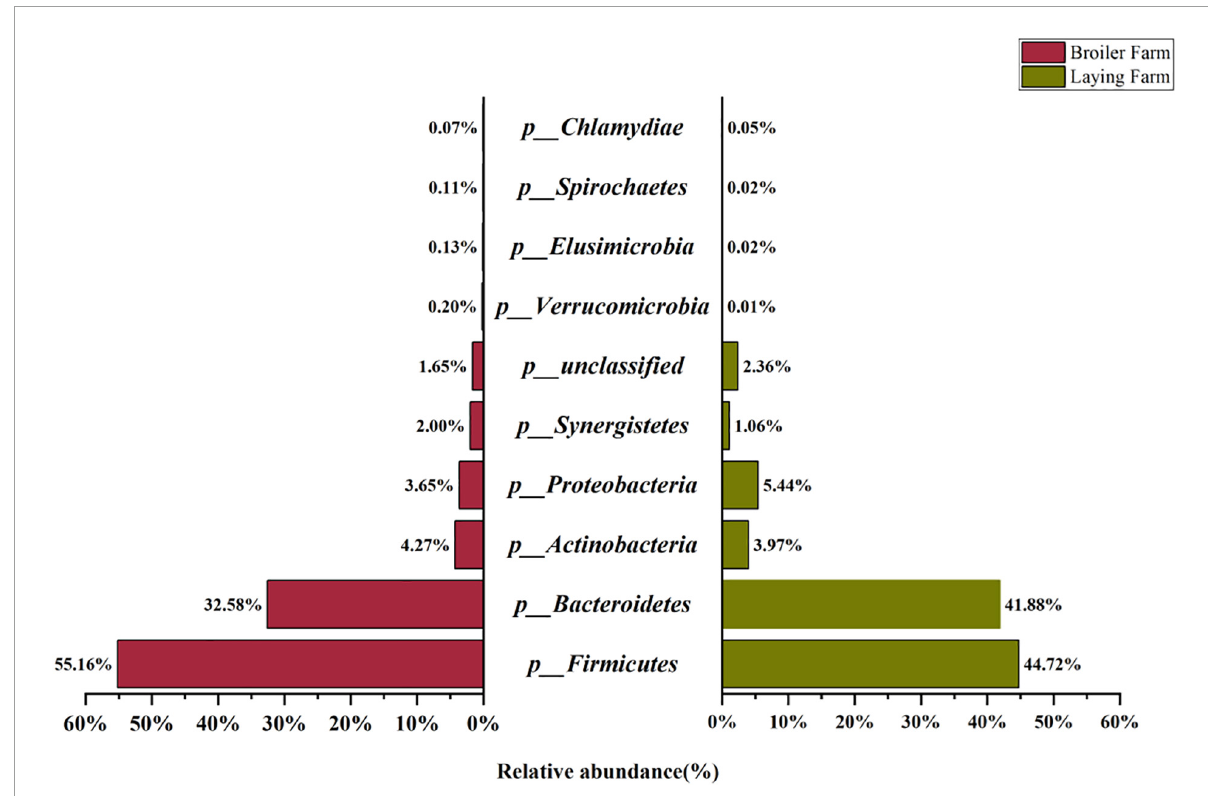
FIGURE1 Top ten relative abundance of taxonomic composition at the phylum level in broiler and laying farm